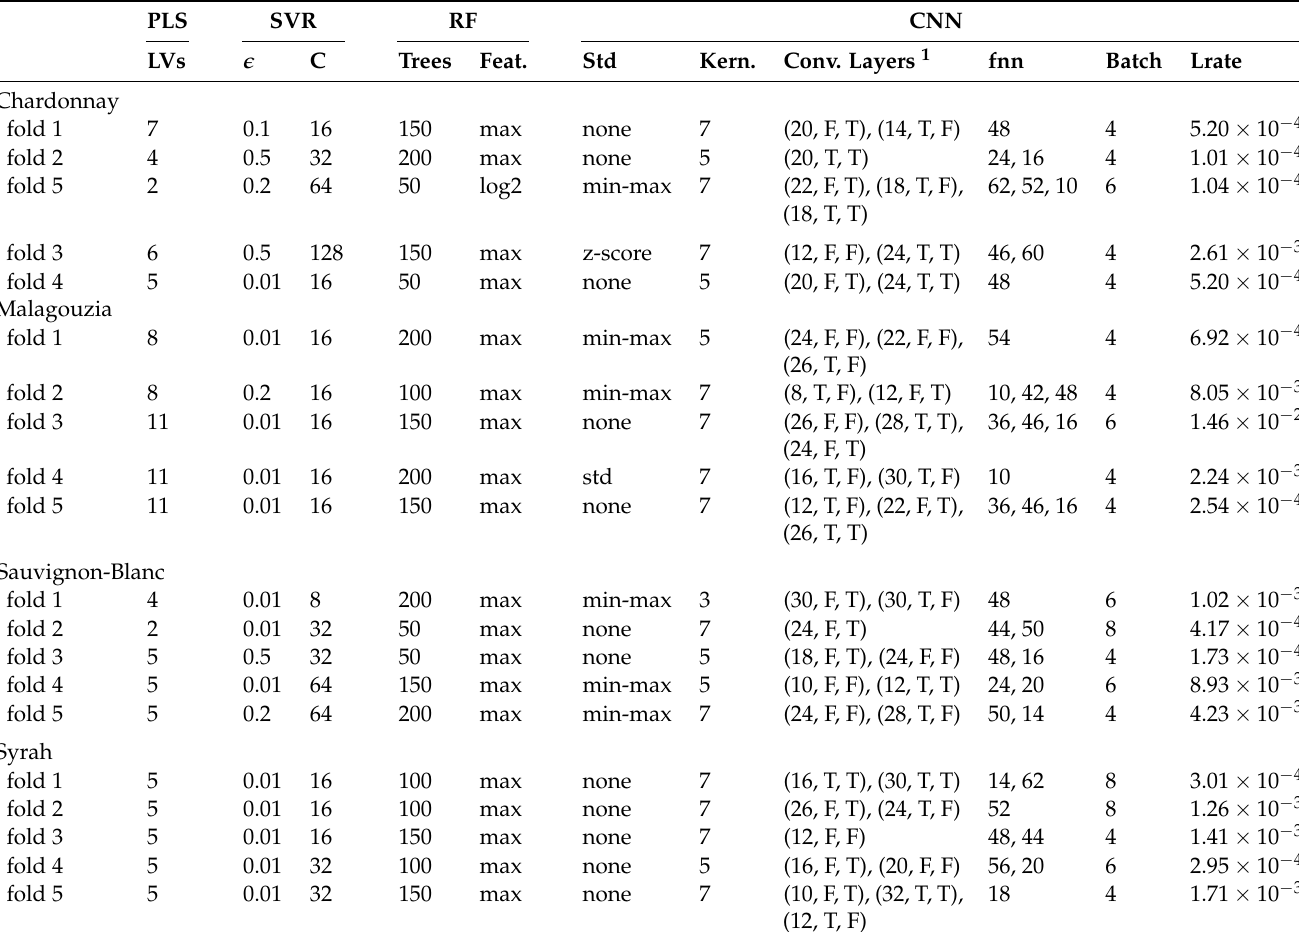
Table A1. The optimal hyperparameters for all the developed